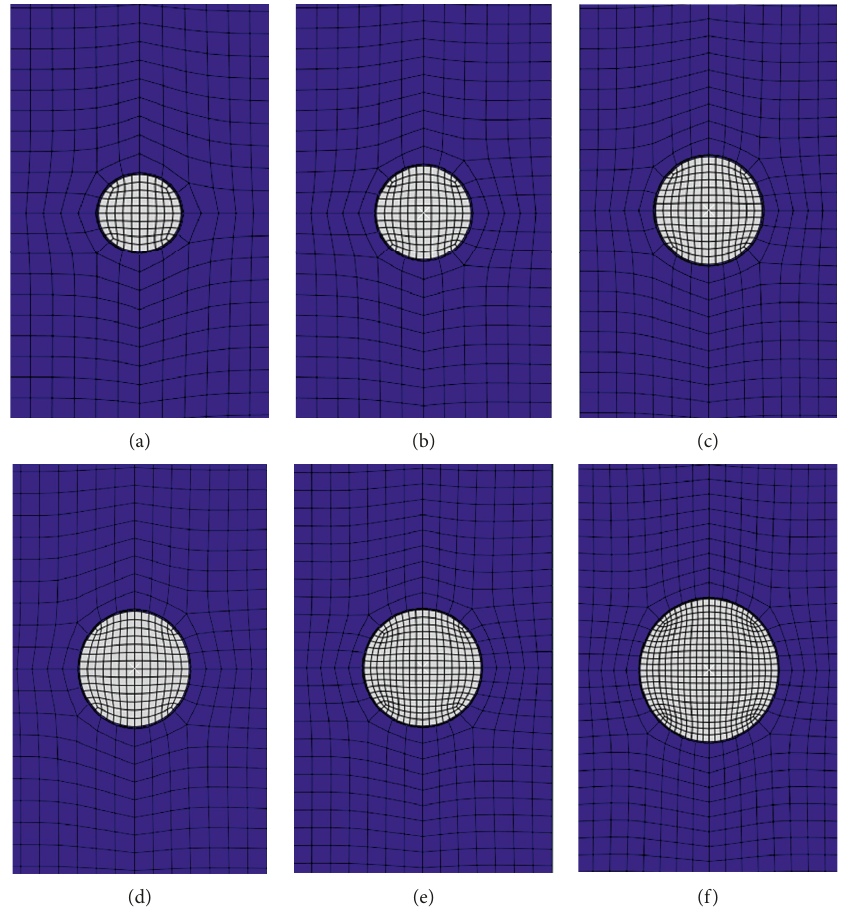
Figure 8: Finite element model of different steel cord diameters. (a) 2.0mm, (b) 2.5mm, (c) 3.0 mm, (d) 3.5mm, (e) 4.0 mm, and (f) 4.5mm.